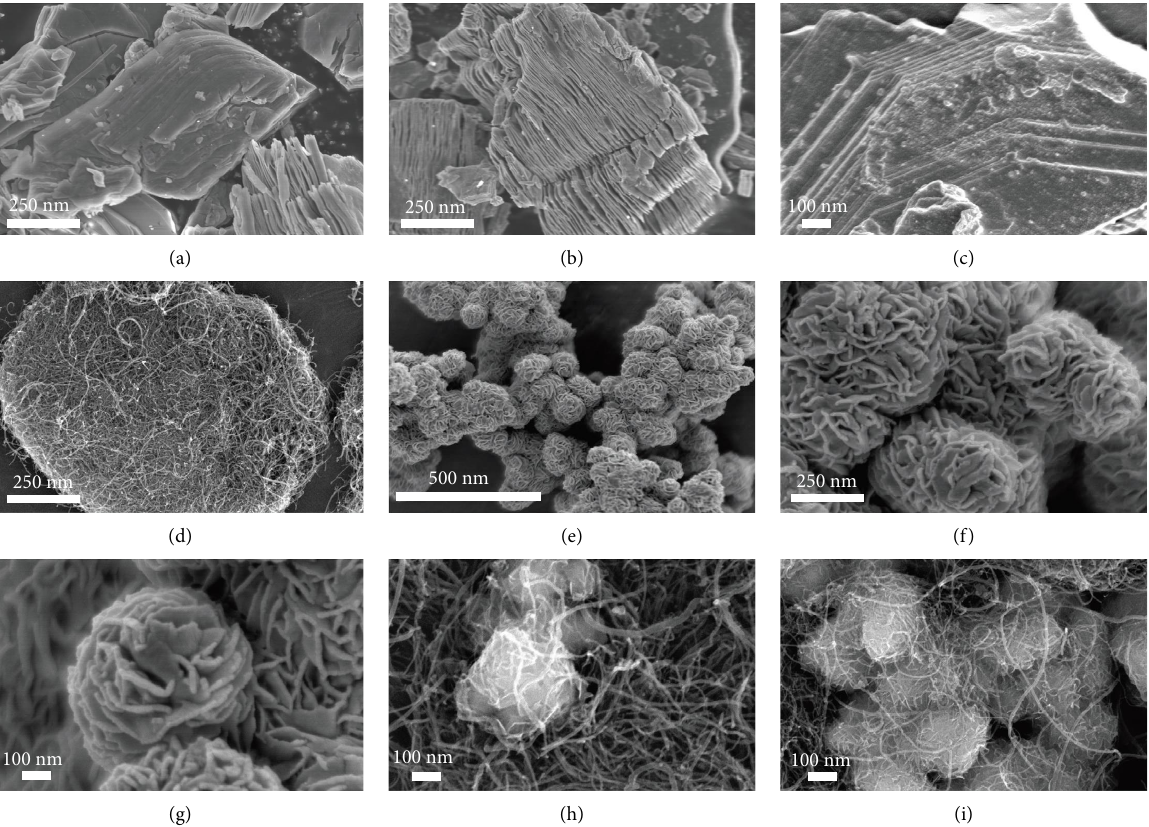
Figure 3: SEM images of (a), (b), and (c) MXene, (d) MXene@CNT, (e), (f), and (g) MoWS2, (h) WS2@CNT, and (i) MoWS2@MXene@ CNT.